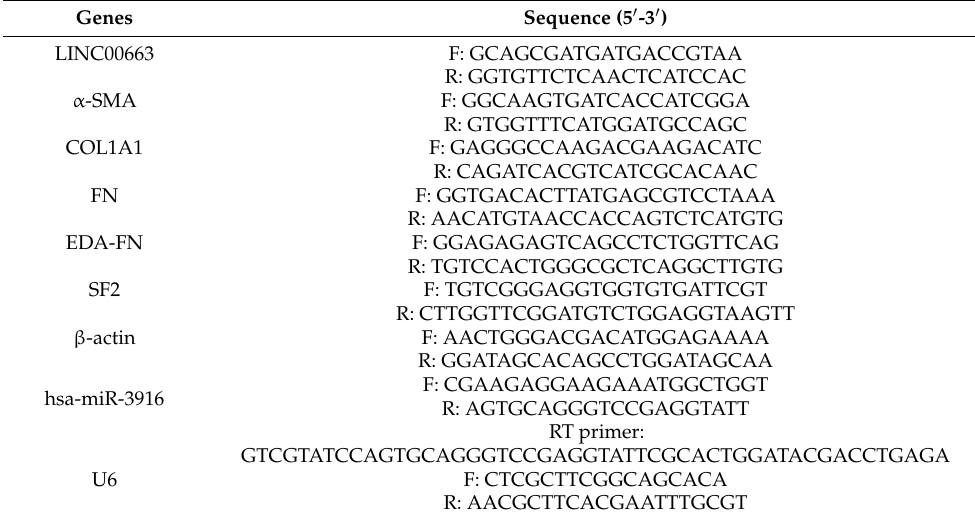
Table 1. Forward and reverse primers for real-time